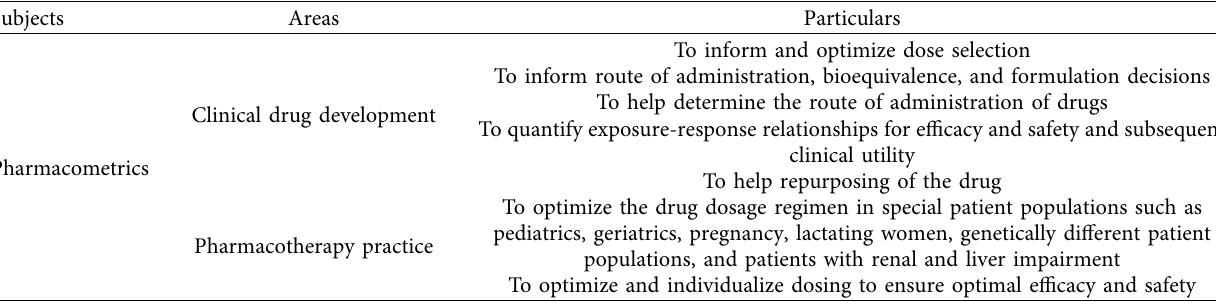
Table 1: Advantages of